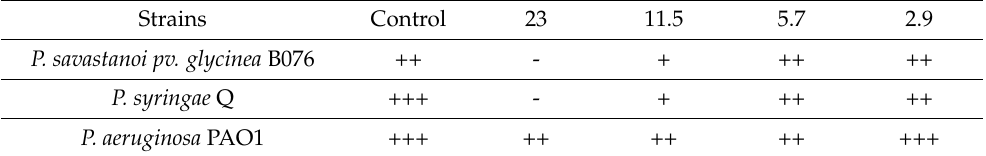
Table 4. Effect of TEO (mg/mL) on the swimming of P. syringae strains and P. aeruginosa PAO1. Strains Control